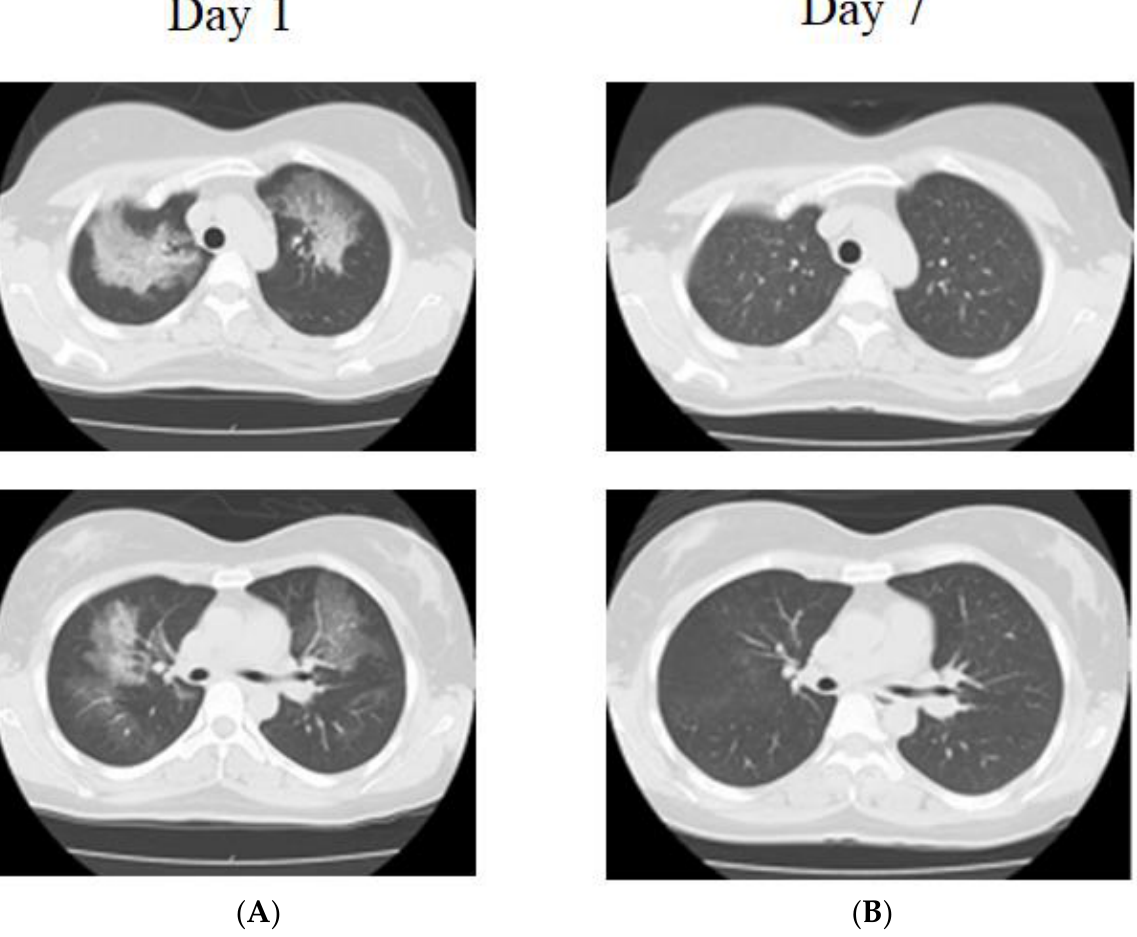
Figure 2. Chest X-ray and chest computed tomography (CT) in case 2. ( A ) Bilateral diffuse, ground- glass opacity predominates in the upper lung fields, with a partially mosaic pattern, and no pleural nadir shadow. There is no pleural effusion (Day 1). ( B ) Improved completely (Day 7).